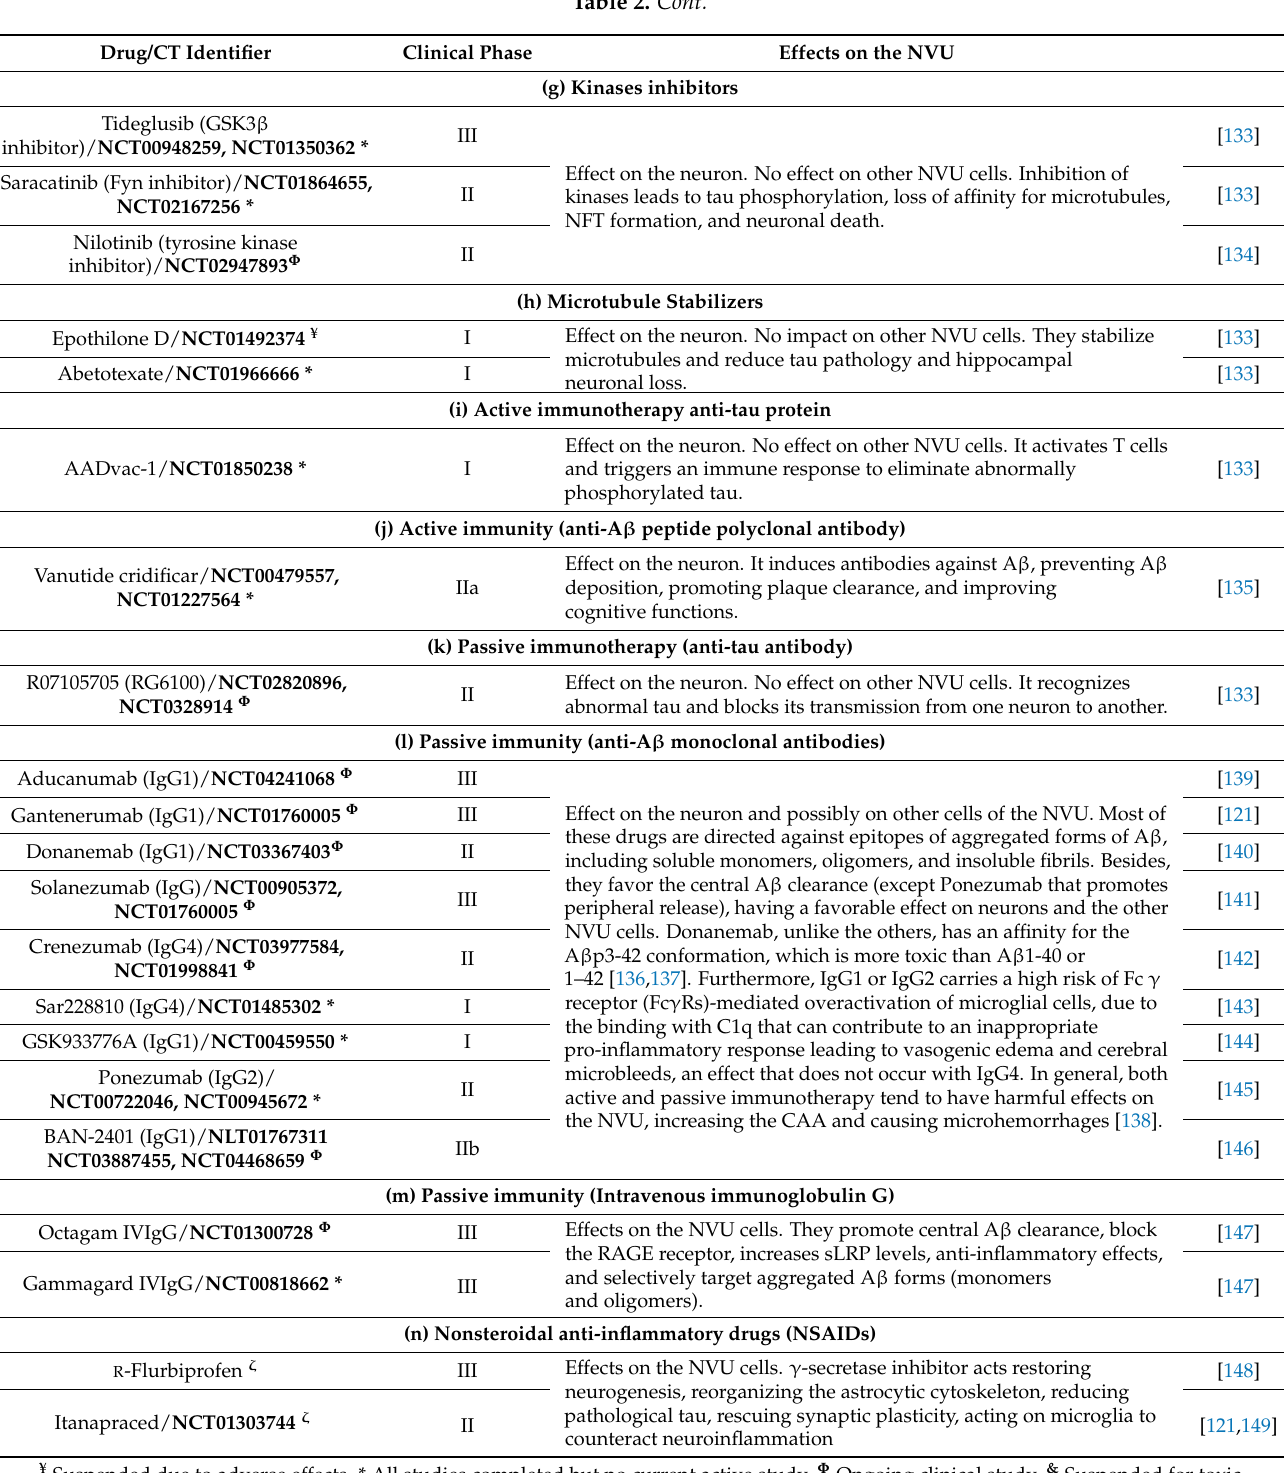
Table 2. Cont. Drug/CT Identifier Clinical Phase Effects on the